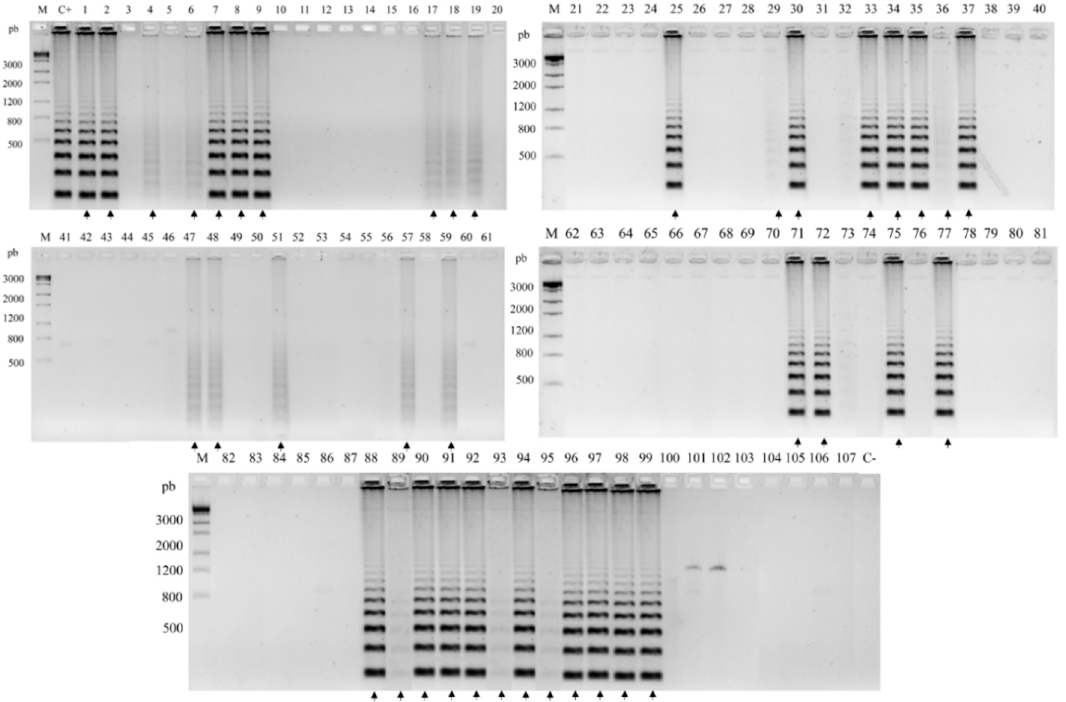
Figure 4. Positive environmental samples for FOM by RCA screening. Molecular marker 1 kb. C+, positive control F. monophora (CBS 269.37); C-, negative control F. erecta (CBS125760). Bacabeira: 1–5,